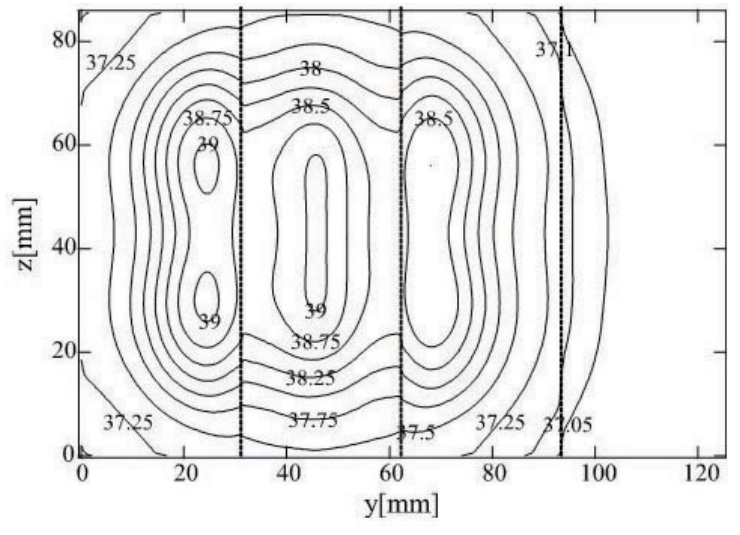
FIGURE 5 . The temperature distribution at the bottom obtained a numerical